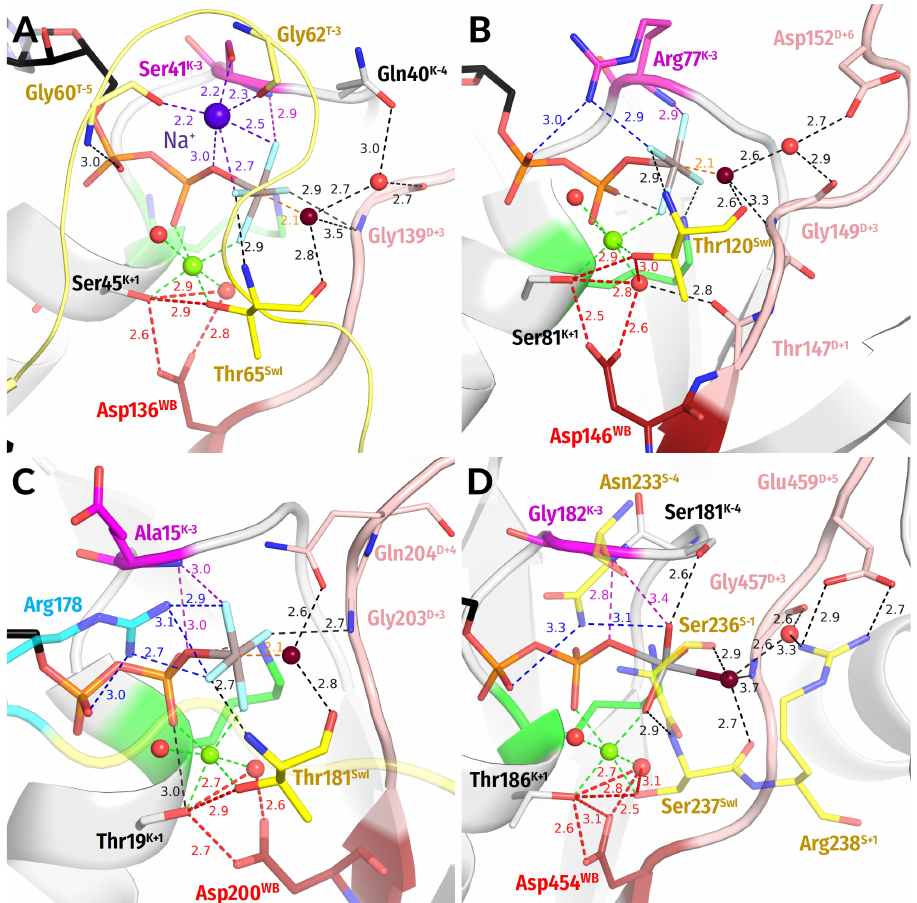
Figure 3. Representative NTPases of the TRAFAC class. The residues of Switch I/K-loop are shown in yellow, and the Na + ion is shown in blue. The tentative proton routes are shown by thick red dashed lines. Other colours as in Figure 1E,F. All distances are given in ångströms. ( A ) Dynamin (PDB ID 2X2E, [72]). ( B ) Atlastin-1 (PDB ID 6B9F, [92]). ( C ) G α 12 subunit of a heterotrimeric G-protein (PDB ID 2ODE, [84]). ( D ) Myosin II of Dictyostelium discoideum (PDB ID 1VOM